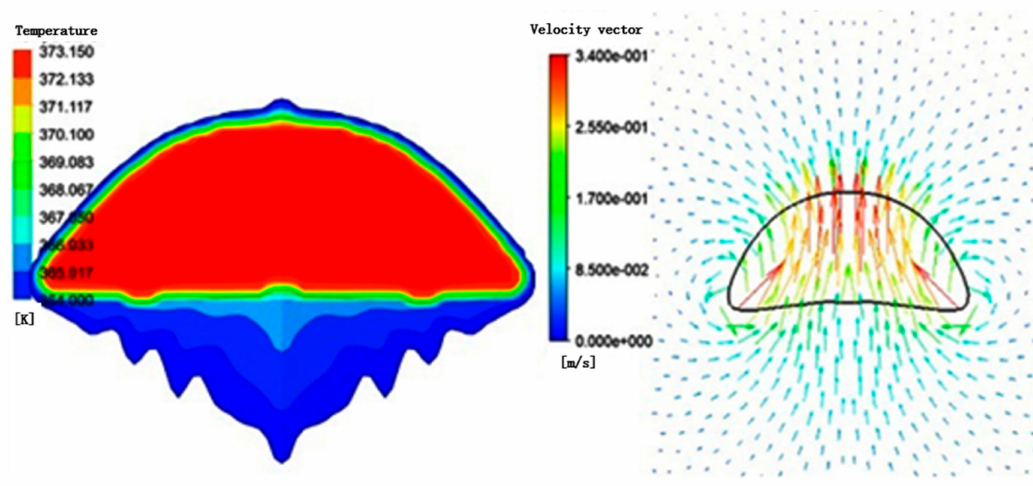
Figure 10. Temperature field cloud diagram and velocity vector